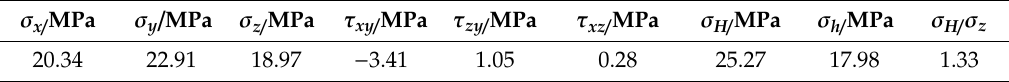
Table 8. Principal stress results for the test points in the PDS No. 11 coal mine.